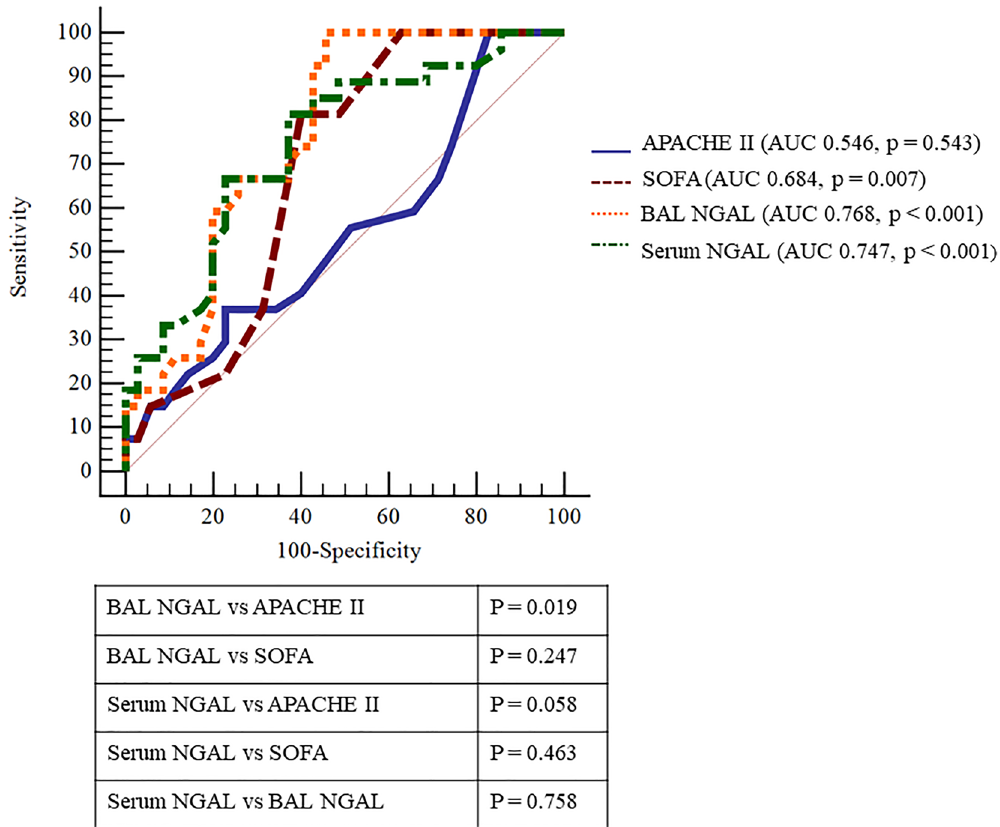
Figure 4. Receiver operating characteristic curve for intensive care unit mortality. At baseline, BAL NGAL (AUC 0.768, 95% CI 0.643–0.866, p < 0.001) and serum NGAL (AUC 0.747, 95% CI 0.621–0.849, p < 0.001) levels showed fair predictive power. SOFA score (AUC 0.684, 95% CI 0.554–0.796, p = 0.007) also showed significant predictive power. Baseline NGAL levels showed comparable predicted power compared to SOFA scores (serum P = 0.463, BAL p = 0.247). In addition, serum NGAL showed a predicted power comparable to that of BAL NGAL (p = 0.758). AUC area under the curve, BAL bronchoalveolar lavage, NGAL neutrophil gelatinase- associated lipocalin, APACHE II Acute Physiology and Chronic Health Evaluation II, SOFA sequential organ failure assessment.